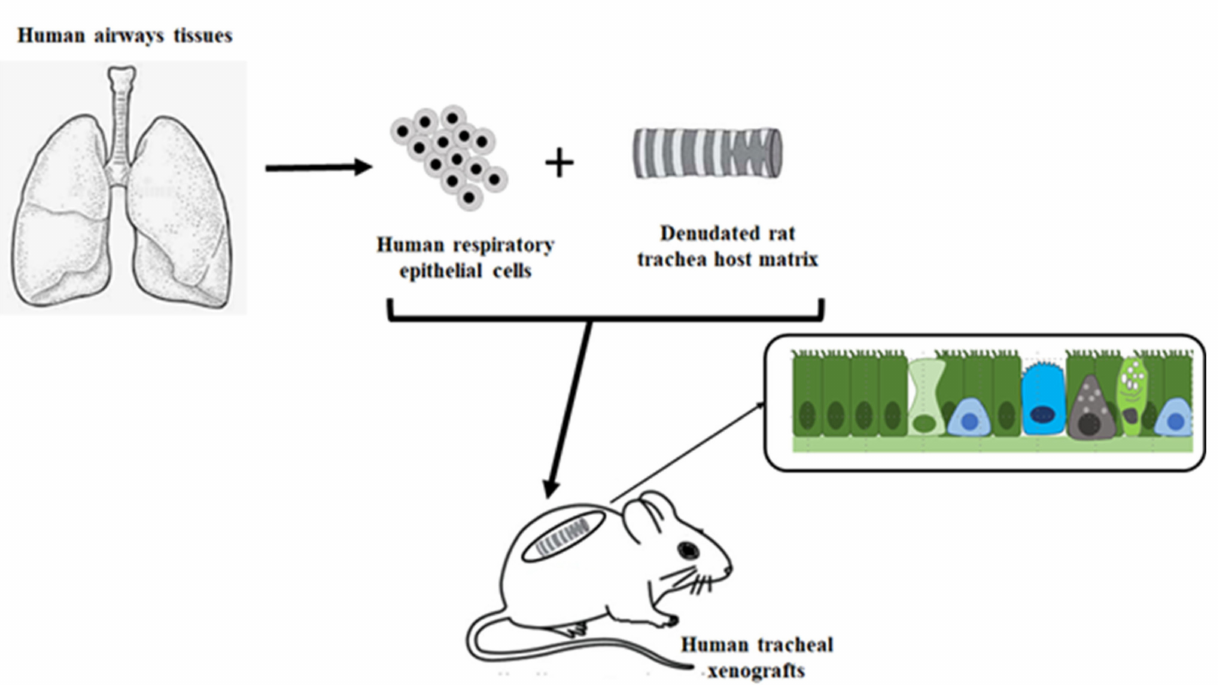
Figure 3. The “air-opened” nude mouse xenograft model. Dissociated airway epithelial cells are seeded into the lumen of a denuded rat trachea tied at their end to sterile tubing. The assembly is subcutaneously implanted in the flank of a recipient nude mouse. Epithelial repair and regeneration steps result in the generation of a well-differentiated mucociliary epithelium